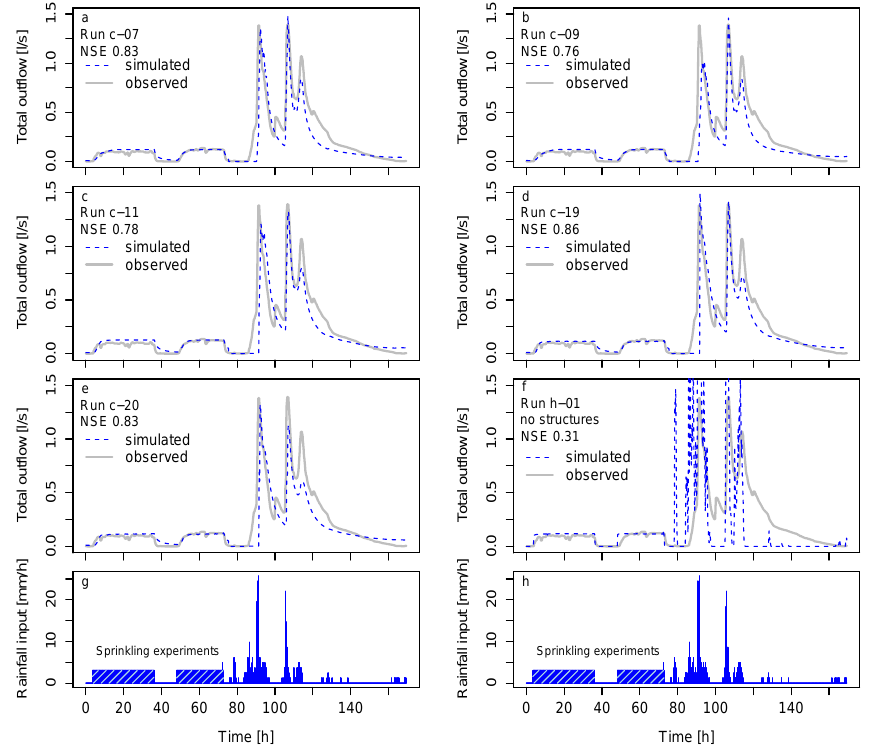
Fig. 3. Observed hydrographs and simulated total outflow of the five acceptable basic model set-ups (a–e) and of a set-up without any structures (f) . The identifier and NSE are given in the upper left corner of each panel. The total outflow is the sum of surface and subsurface runoff. In case of the acceptable model set-ups (a–e) total outflow mainly was subsurface flow, while surface runoff was all dominant for the set-up without any structures (f) . The rainfall input (g, h) was either provided by the sprinkling experiments at the experimental plots or by natural rainfall; the input rate is related to the total hillslope area. Time is given as hours since beginning of the discharge measurement at the